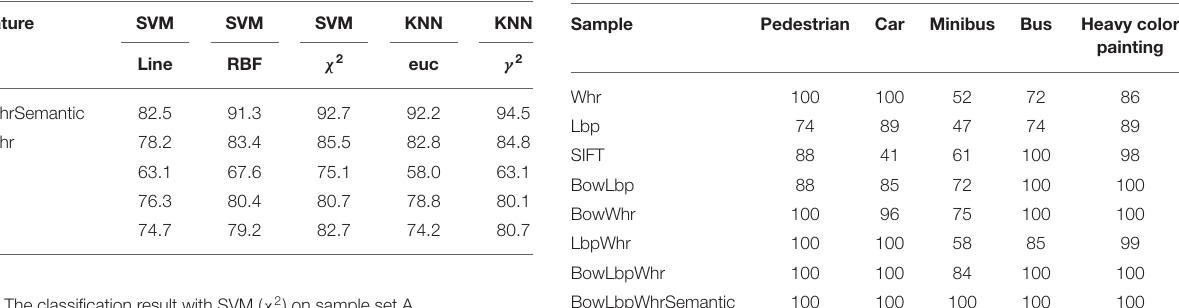
TABLE 4 | The classification result with SVM ( χ 2 ) on sample set A. Sample